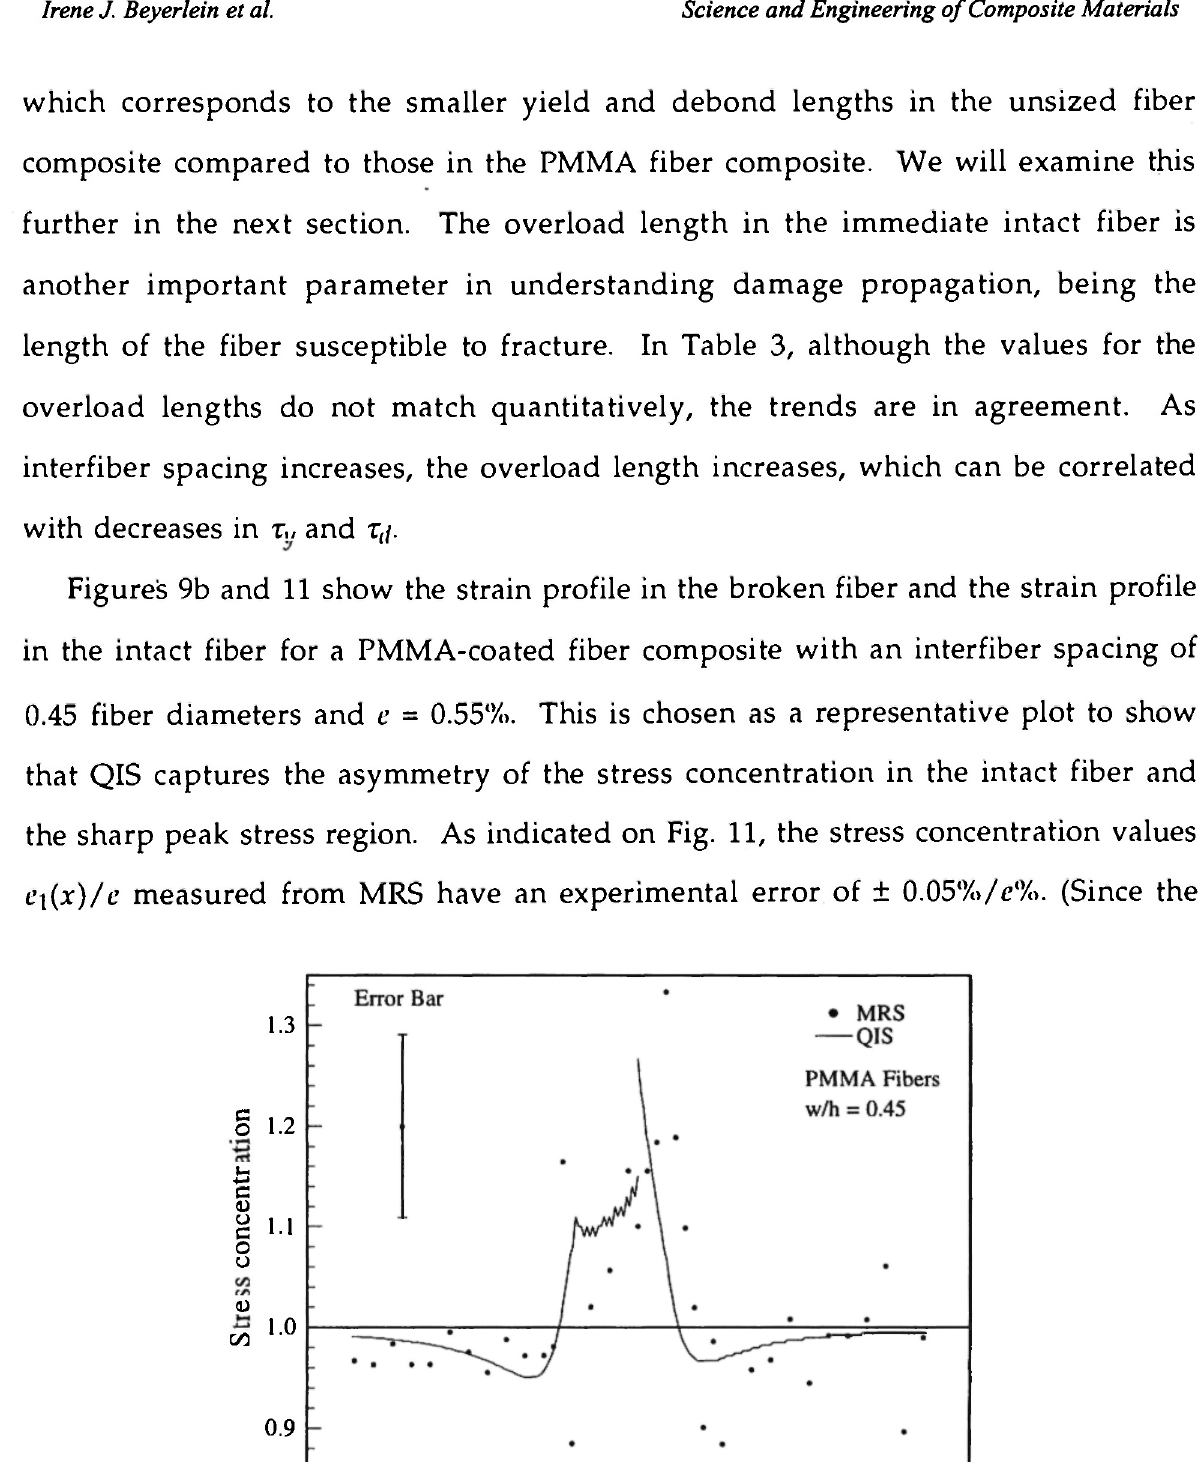
Fig. 11: Comparison ot the QIS predicted and MRS mapped stress concentration profiles in the intact fiber adjacent to a broken one in a P M MA coated fiber composite for ιυ/h -